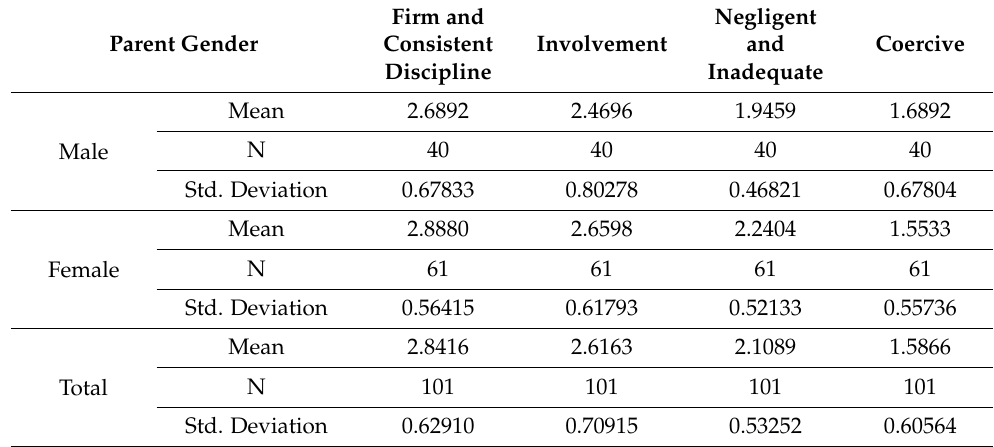
Table 7. Means and standard deviations of parenting practices by gender. Firm and Negligent Parent Gender Consistent Involvement and Coercive Discipline Inadequate Mean 2.6892 2.4696 1.9459 1.6892 N 40 40 Male Std. Deviation